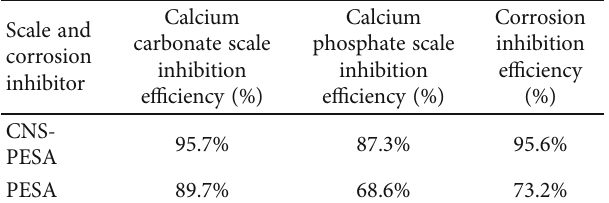
Table 2: Technical and economic indexes of CNS-PESA and PESA. Scale